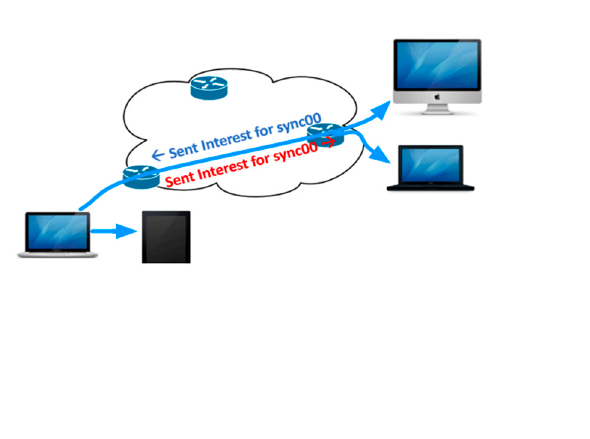
7 of 19 Figure 4. NDN over KubeEdge general network architecture in two regions.